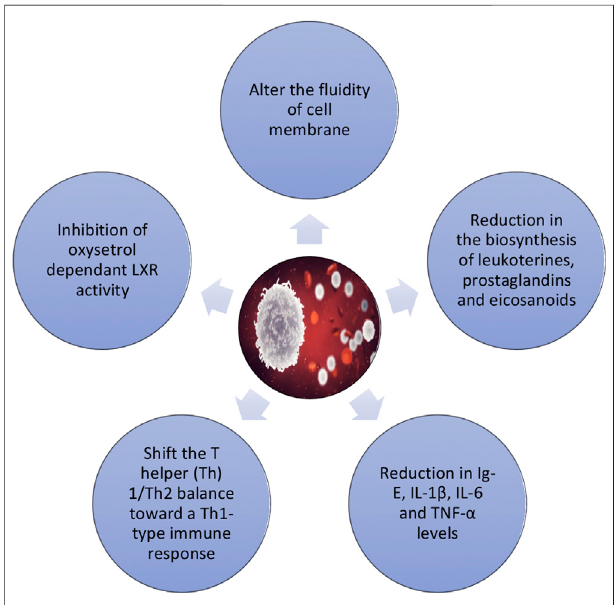
FIGURE 5 | Immunomodulatory effects of